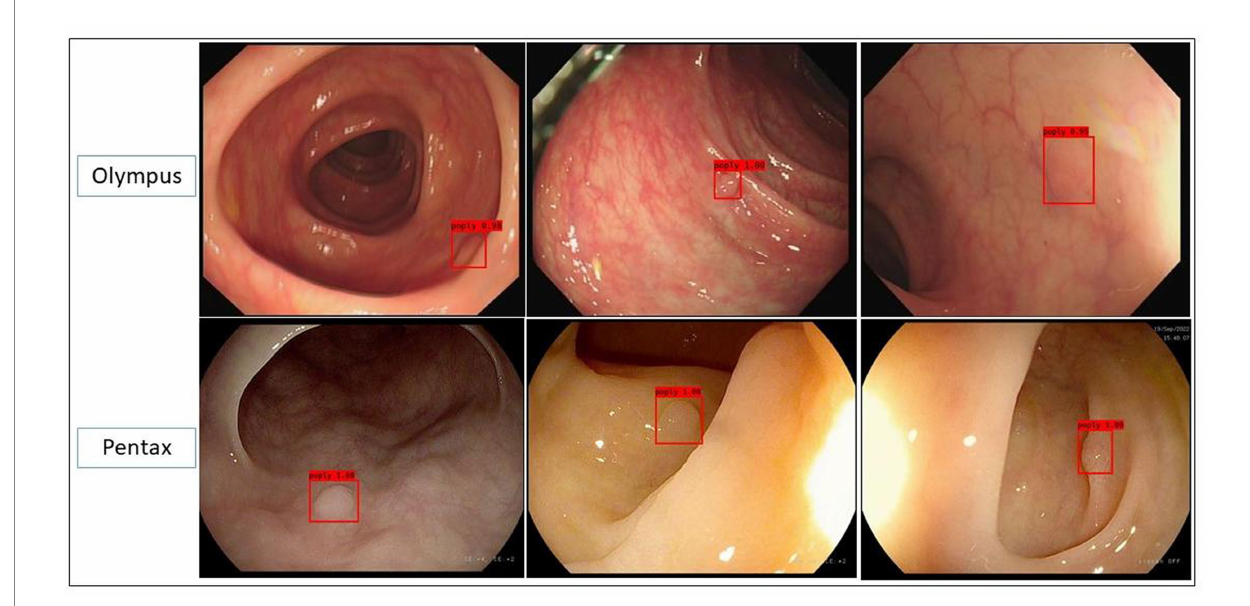
FIGURE 1 Representative images predicted by the polyp recognition model in the polyp dataset in both Olympus and Pentax brands.